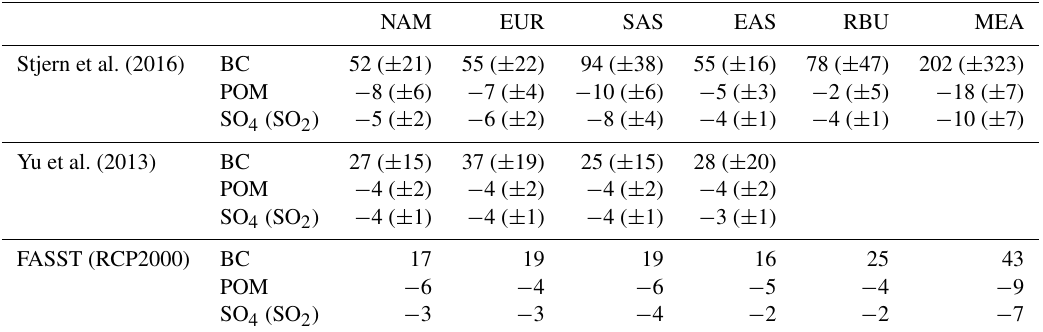
Table 11. Regional-to-global direct radiative forcing efficiencies for PM 2 . 5 precursors (mWm − 2 Tg − 1 of annual emissions) for the larger source–receptor regions in earlier studies, and from FASST, aggregated to similar regional definitions. Values in brackets represent 1SD (standard deviation) from the respective reported model ensembles.